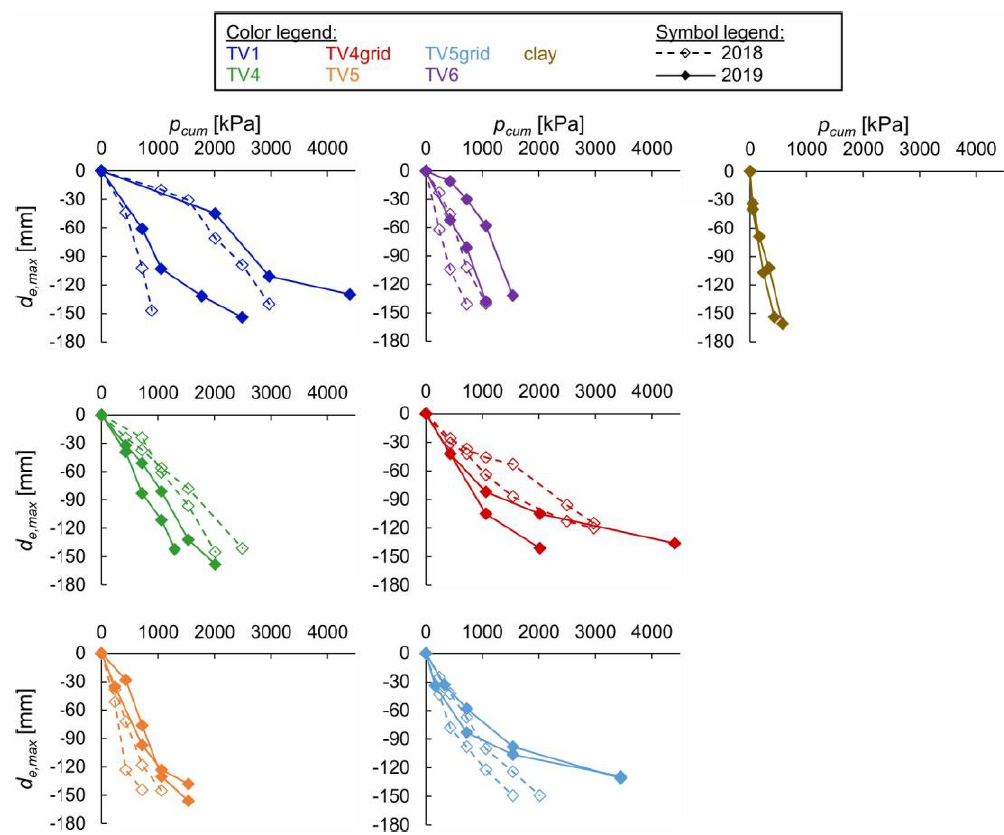
Figure 7. Maximum erosion depth d e,max as function of the cumulative wave impact pressure p cum for different vegetated covers. TV1 = species-poor grass-dominated mixture, TV4 = grass-herb mixture, TV5 = species-rich herb-dominated EcoDike mixture, TV6 = species-rich herb-dominated ready-mix, and grid = geogrid reinforcement.